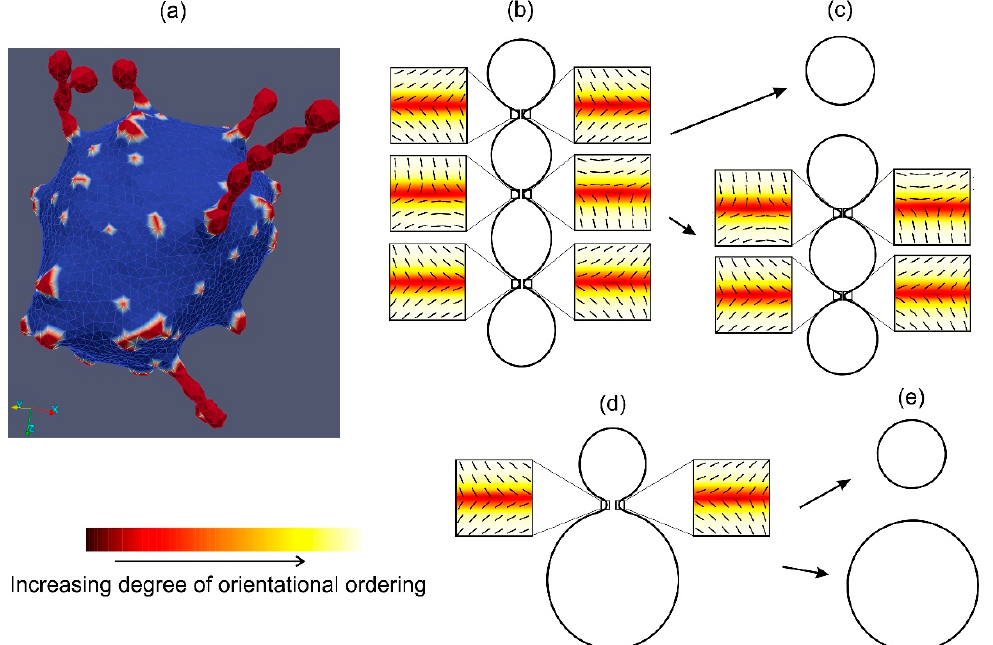
Figure 1. Typical vesicle shapes calculated by MC simulations [11] for the two-component membrane composed of highly curved isotropic flexible nanodomains (marked in red) and the nanodomains with zero intrinsic curvature (marked in blue) are presented in panel ( a ). Membrane nanodomains with high intrinsic curvature (red) are accumulated in undulated membrane protrusions. Panels ( b , c ) show the orientational ordering profiles in the necks of undulated membrane buds/protrusions. Topological antidefects are accumulated in the necks. Consequently, the shape with three prominent thin necks ( b ) is transformed into two distinct closed membrane shapes ( c ) as a result of the rupture of one neck. The positions of antidefects in panels ( b , c ) are marked by small squares. Orientational ordering profiles with the superimposed nematic director fields in the vicinity of topological antidefects are magnified. The figure also shows an example of the vesicle budding (panel ( d )) and the formation of the detached daughter vesicle (panel ( e )) driven by the formation of topological antidefects in the neck prior to the fission process. The shape and orientational ordering profile were calculated as described in [22]. Panels ( a – c ) are adapted from [11,22].